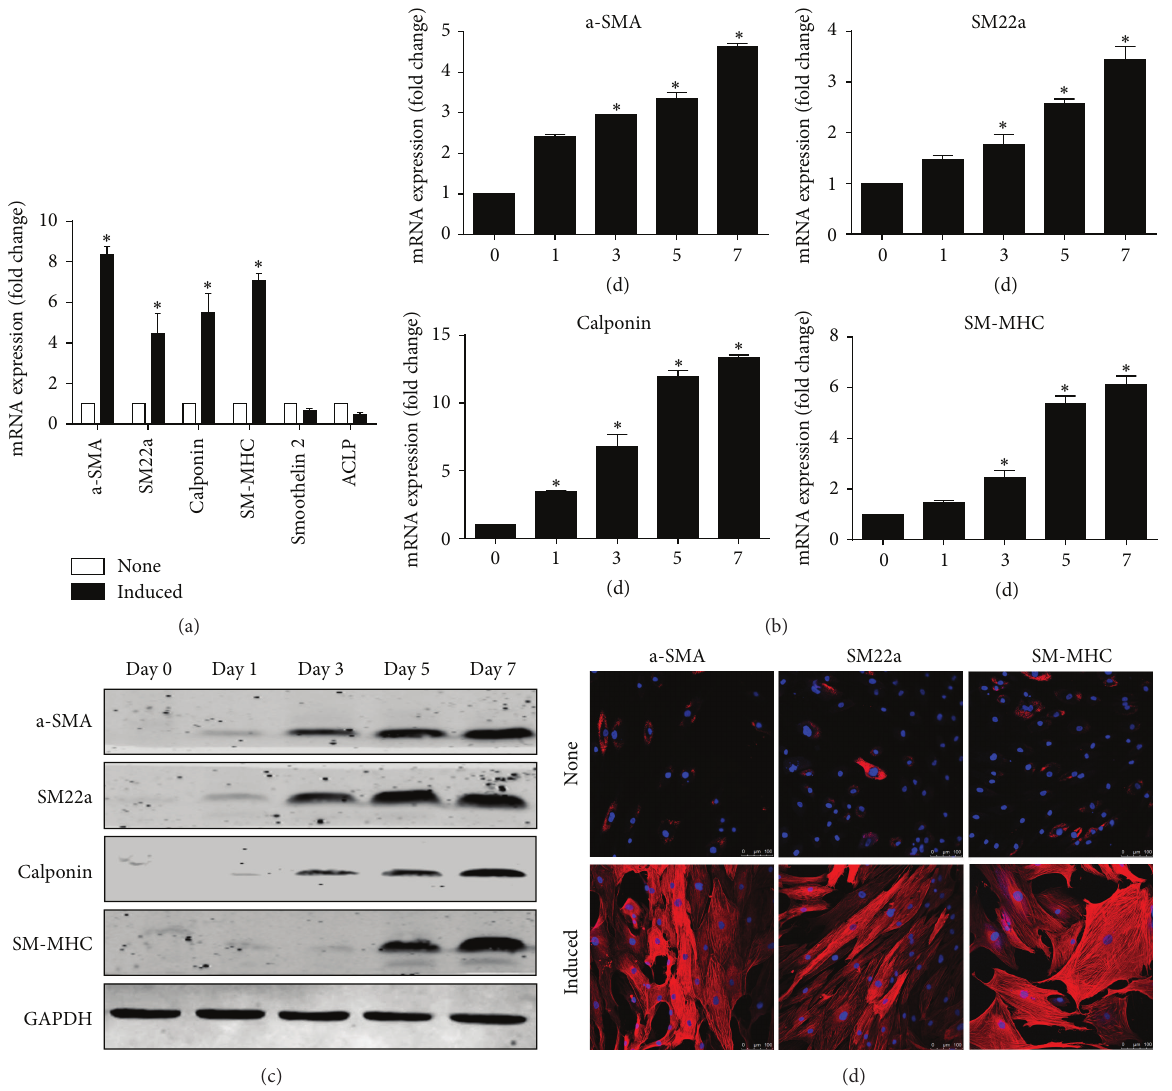
Figure 1: Human ASCs were induced to differentiate into SMCs by treatment with TGF- 𝛽 1 and BMP4 for 7 days. (a) Quantitative real-time PCR experiments were carried out to measure the expression level of smooth muscle specific markers. (b, c) Time course of the expression of SMC differentiation markers detected by qRT-PCR and western blot analysis, respectively. (d) Immunofluorescent staining of smooth muscle specific markers (red), respectively. Nuclear were counterstained with DAPI (blue). Scale bars: 100 𝜇 m. Data represent means ± SE, 𝑛 = 3 ( ∗ 𝑃 < 0.05 versus